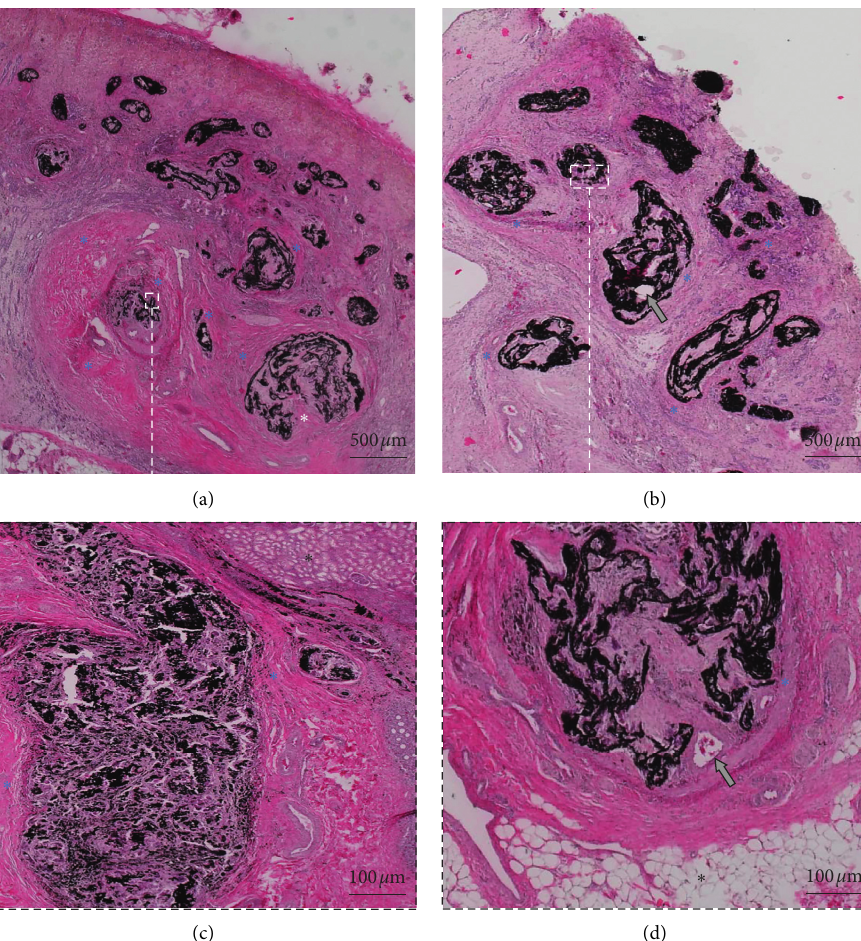
Figure 3: Corticomedullary kidney histological analysis with light microscopy: (a, c) after embolization with AS18, infiltration of arterial lumens by granulomas (giant cells, fibroblasts, polynuclear cells, and lymphocytes) (blue asterisks) without any recanalization (white asterisk); (b, d) after embolization with S18 ® , infiltration of arterial lumens by granulomas (blue asterisks) and recanalization of embolized arteries (grey arrows). (a, b): × 20 magnification (c, d): × 100